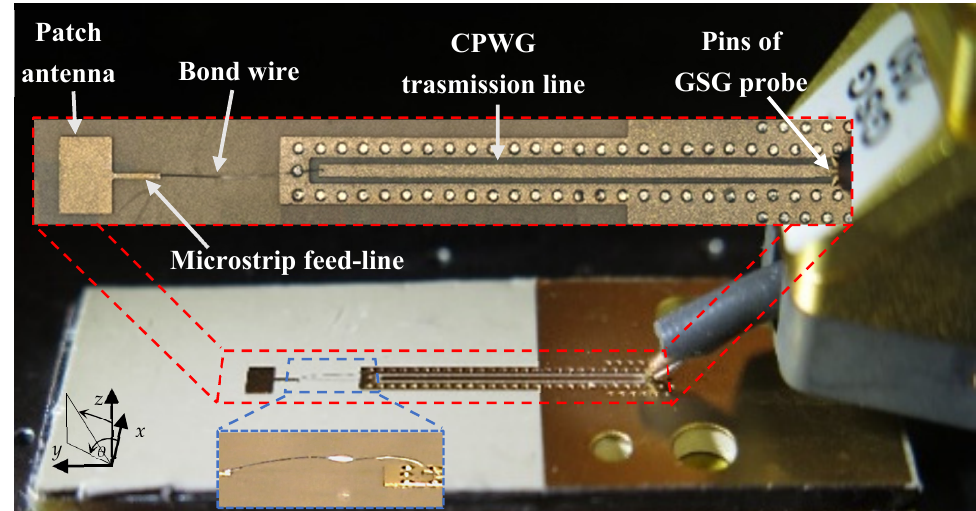
Figure 2. Photograph of the antenna under reflection coefficient measurements.